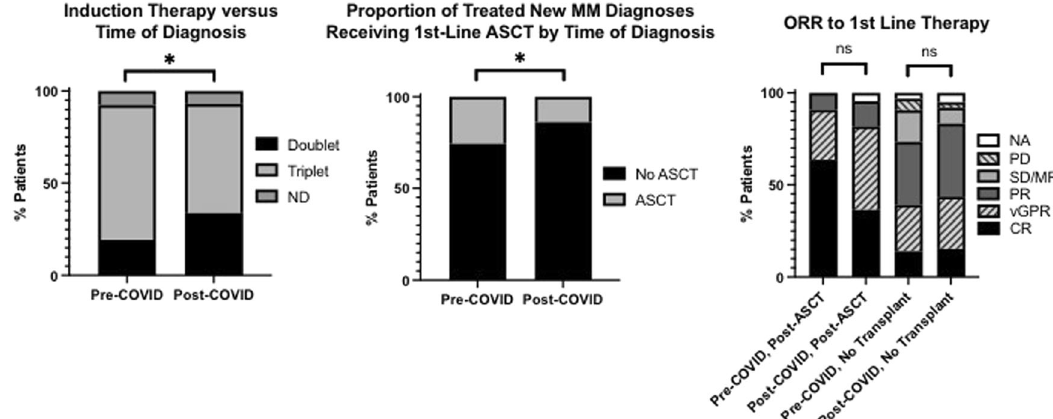
Fig. 5 Induction treatment choice and ASCT at fi rst line in those diagnosed from 1st January 2019 – 31st January 2020 (Pre-COVID, n = 86) and from 1st February 2020 – 31st July 2021 (Post-COVID, n = 160) and treated for MM. Overall response (ORR) to fi rst line therapy, delineated by transplant eligibility and diagnosis cohort. ASCT autologous stem cell transplant, TE transplant eligible, TNE transplant ineligible, * p < 0.05.